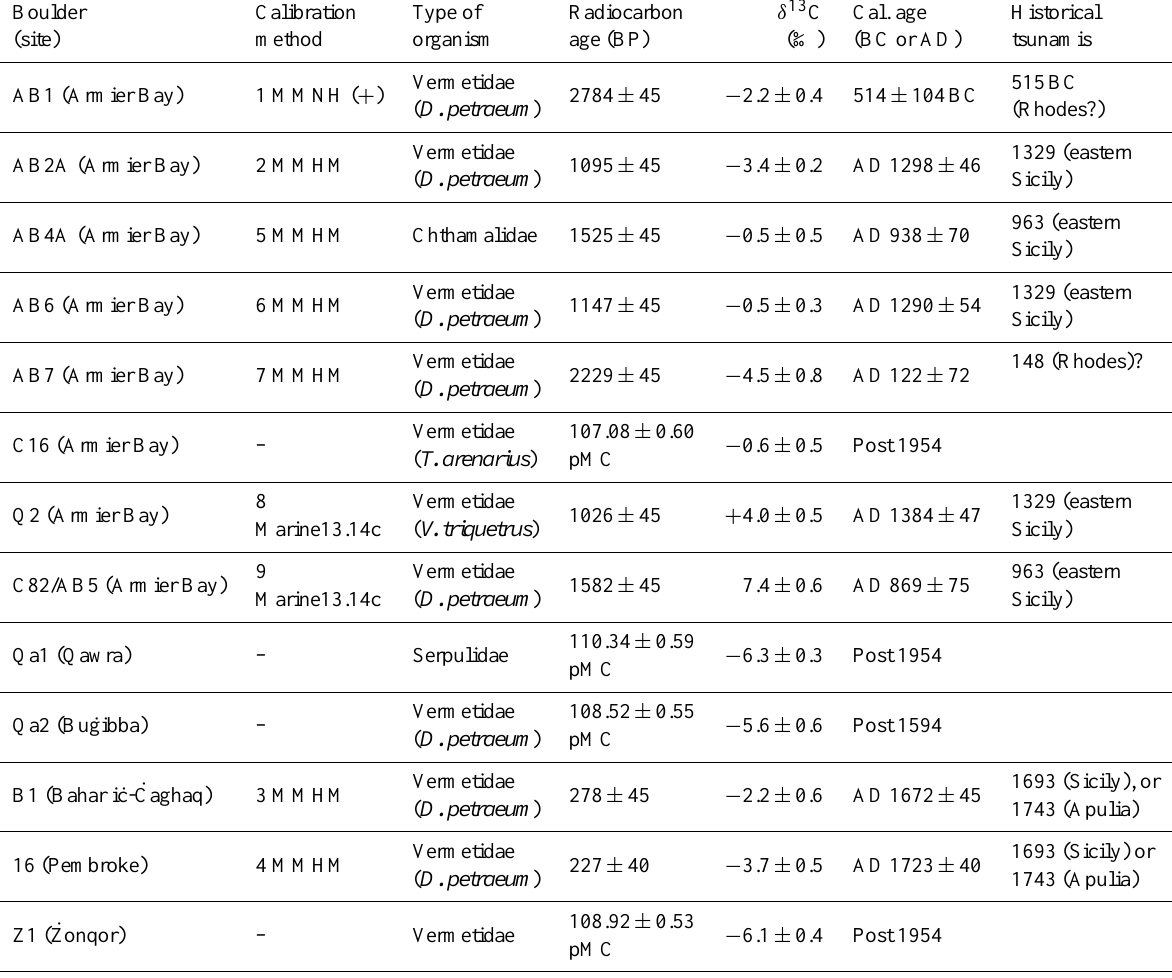
Table 4. Accelerator mass spectrometry (AMS) 14 C dating of marine organisms performed by the CeDaD Laboratory (Centro di Datazione e Diagnostica) of the University of Salento, Brindisi, Italy. The last column lists the historical tsunamis which occurred in the Mediterranean Sea in the ranges of the radiocarbon ages (Tinti et al., 2004; Papadopoulos et al., 2014). pCM denotes percent of modern